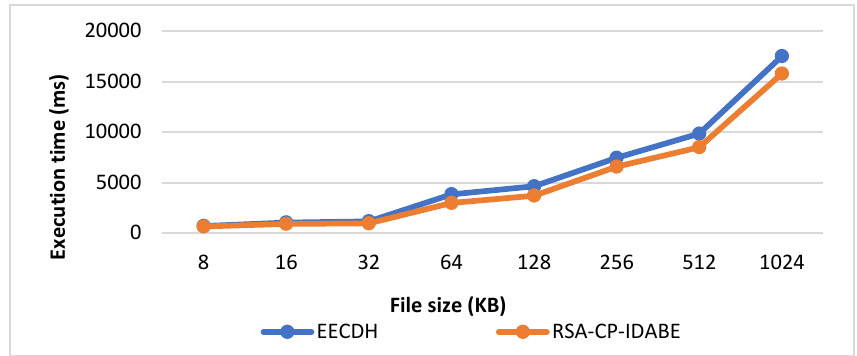
Figure 5. Comparison between the proposed RSA-CP-IDABE and EECDH for execution time.